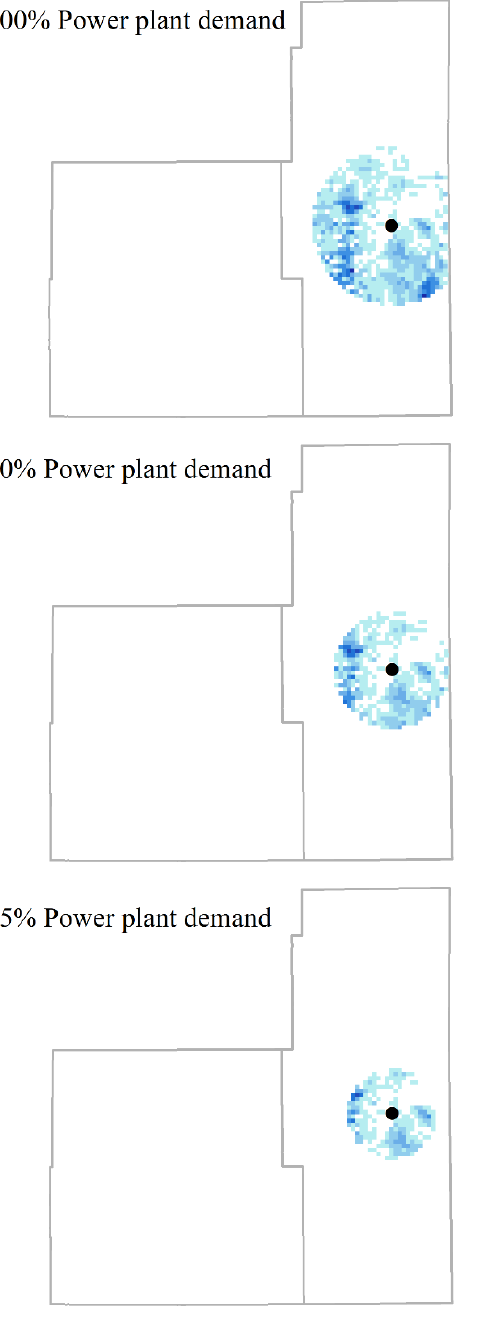
Figure 9. Area of collection required baed on estimated supply to meet 100%, 50%, and 25% of the water demand for power plant demand in Lea